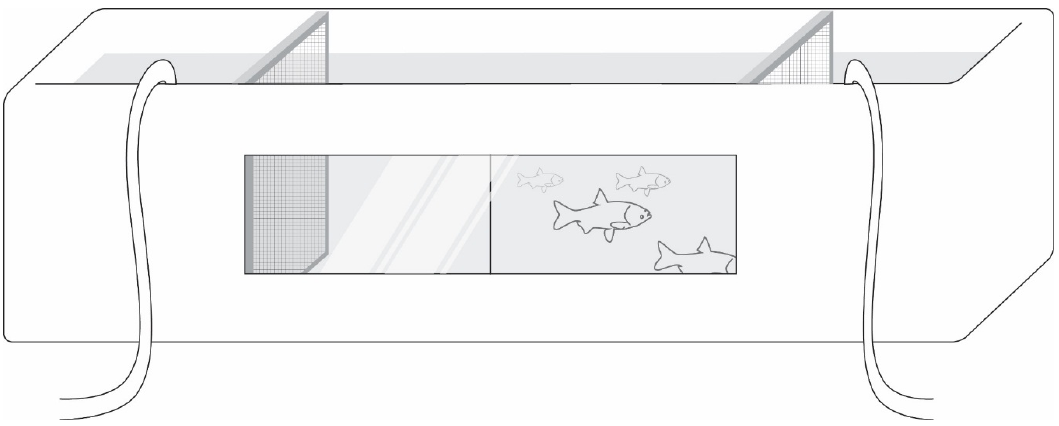
Figure 5. Rectangular test tank used for testing the behavioral activity of PGF 2α -implanted carp odors showing its observation window and the odor injection tubes. The tank measured 2.6 m in length.